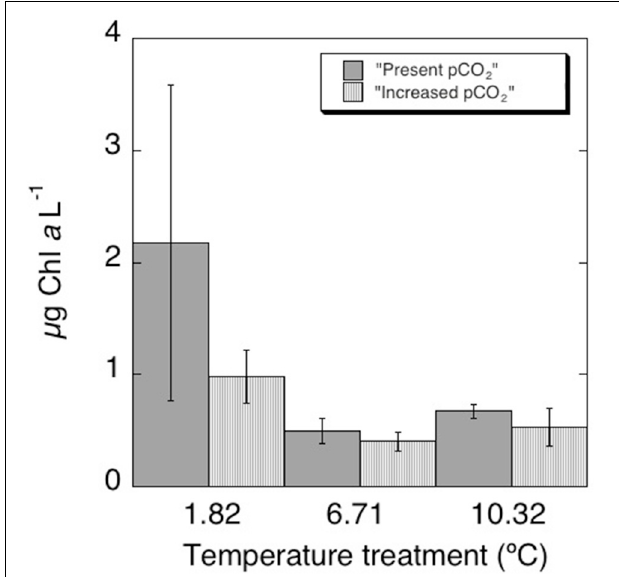
FIGURE 4 | Initial and final values of biovolume ( µ m 3 ) for each group and treatment.